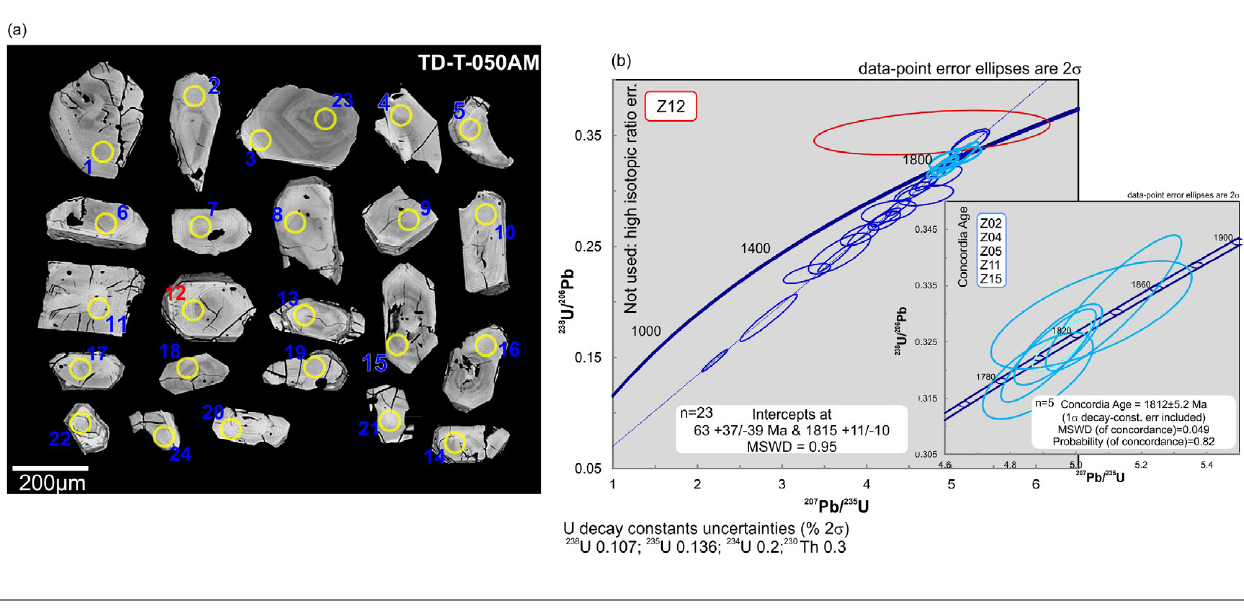
FIGURE 12 - (a) BSE image of zircons of a microgranite from the Paranaíta Intrusive Suite (sample TD-T-050AM) revealing the morphological features, location and ID of pits; and (b) U-Pb concordia diagram and the upper intercept age calculated. The blue color represent the spots results used in the upper intercept calculation, conversely, the red color represent those not